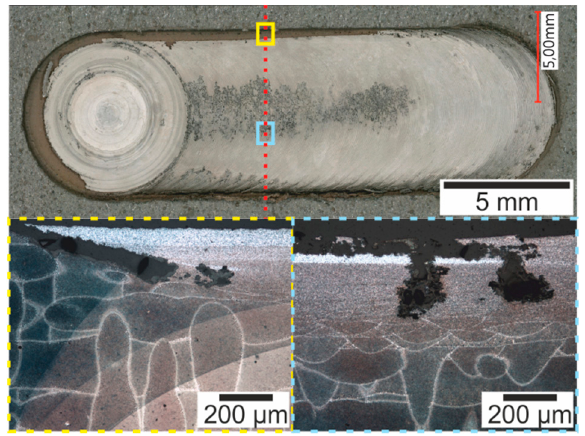
Figure 7. AC-FSP sample after corrosion testing. Top: Macroscopic documentation; Bottom: Cross-sections: perpendicular to processing direction within the boundary region (left) and middle of the FSP zone (right).